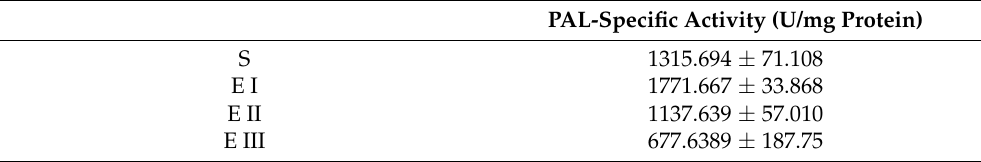
Table 4. PAL activity in different stages of the disease.